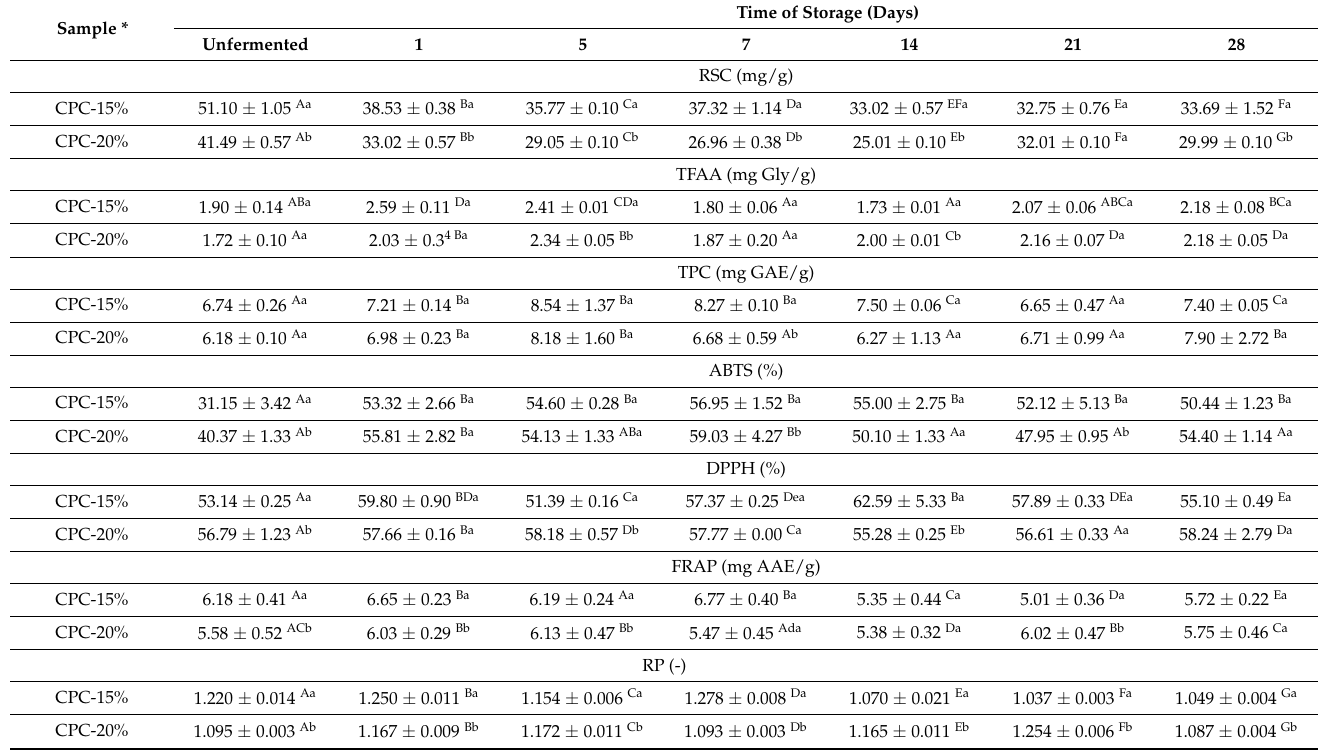
Table 3. Reducing Sugars Content (RSC), Total Free Amino Acids (TFAA), Total Polyphenolics Content (TPC) and Antioxidant Activity of fermented beverages and unfermented (control) samples.